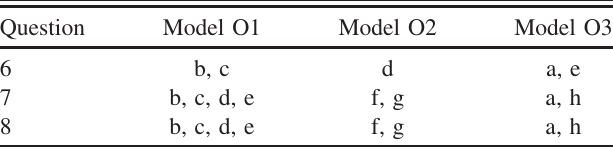
TABLE VII. Models and the multiple-choice options for ques- tions about oscillations.